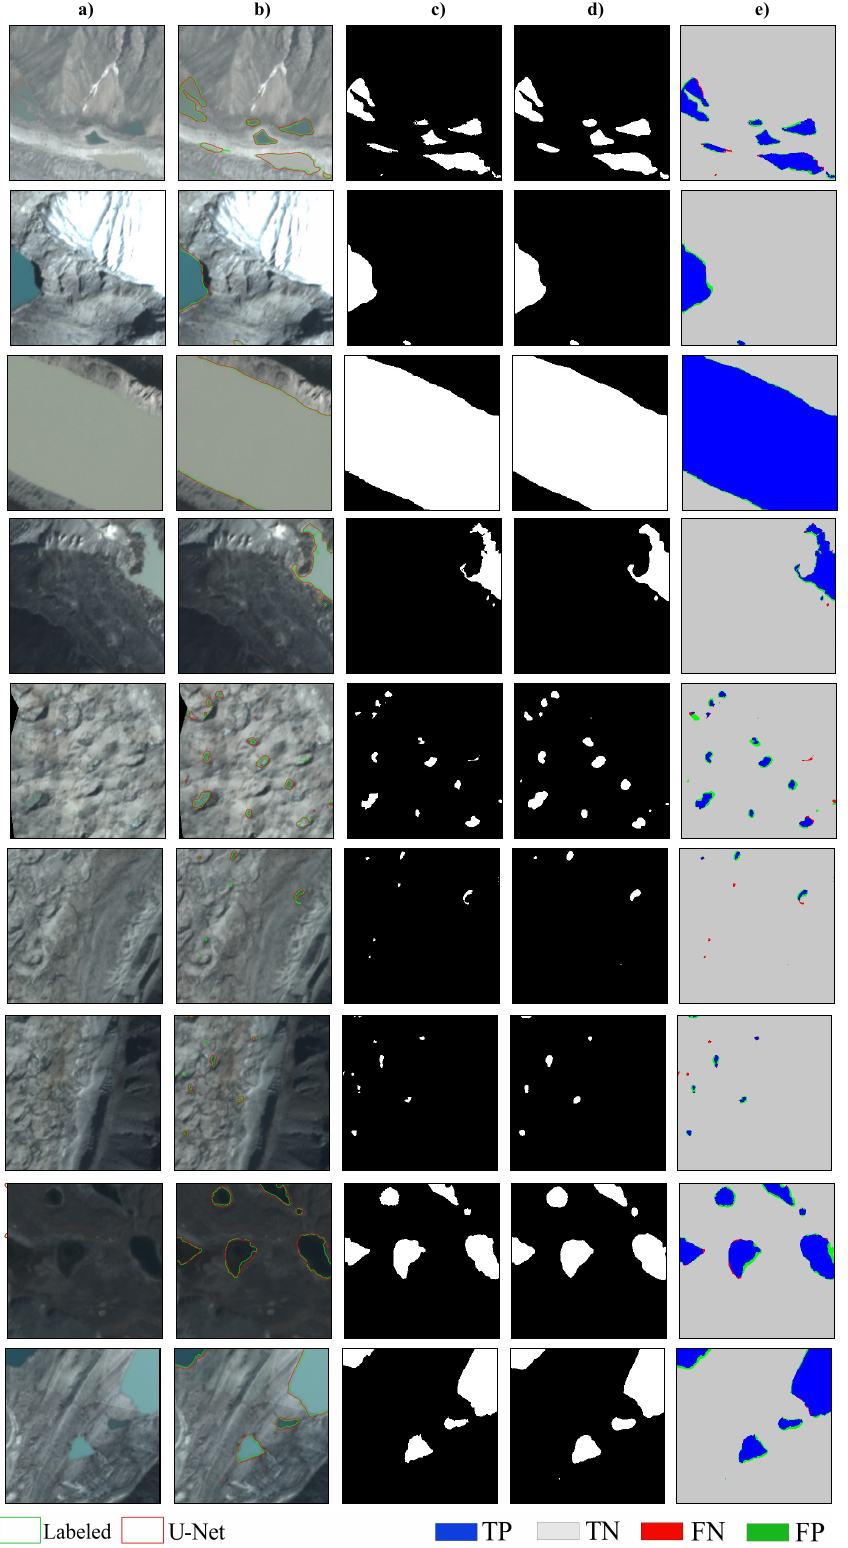
Figure 7. Visualization of the predicted water pixels and comparison with the labeled data for nine tiles of the test data. ( a ) PlanetScope FCC bands 4-3-2. ( b ) Predicted and labeled polygons overlaid on the PlanetScope FCC. ( c ) Labeled binary mask. ( d ) U-Net Predicted binary mask. ( e ) Visualization of the True Positives, True Negatives, False Positives and False